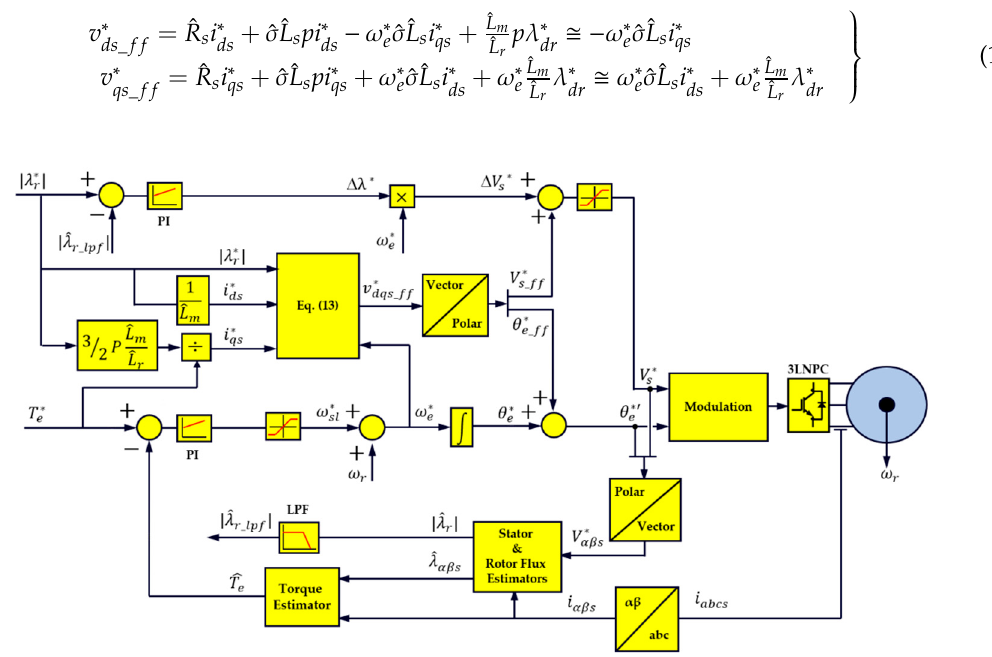
Figure 8. Closed loop V / F with torque / flux control and feedforward (CLVFC&FF) scheme.